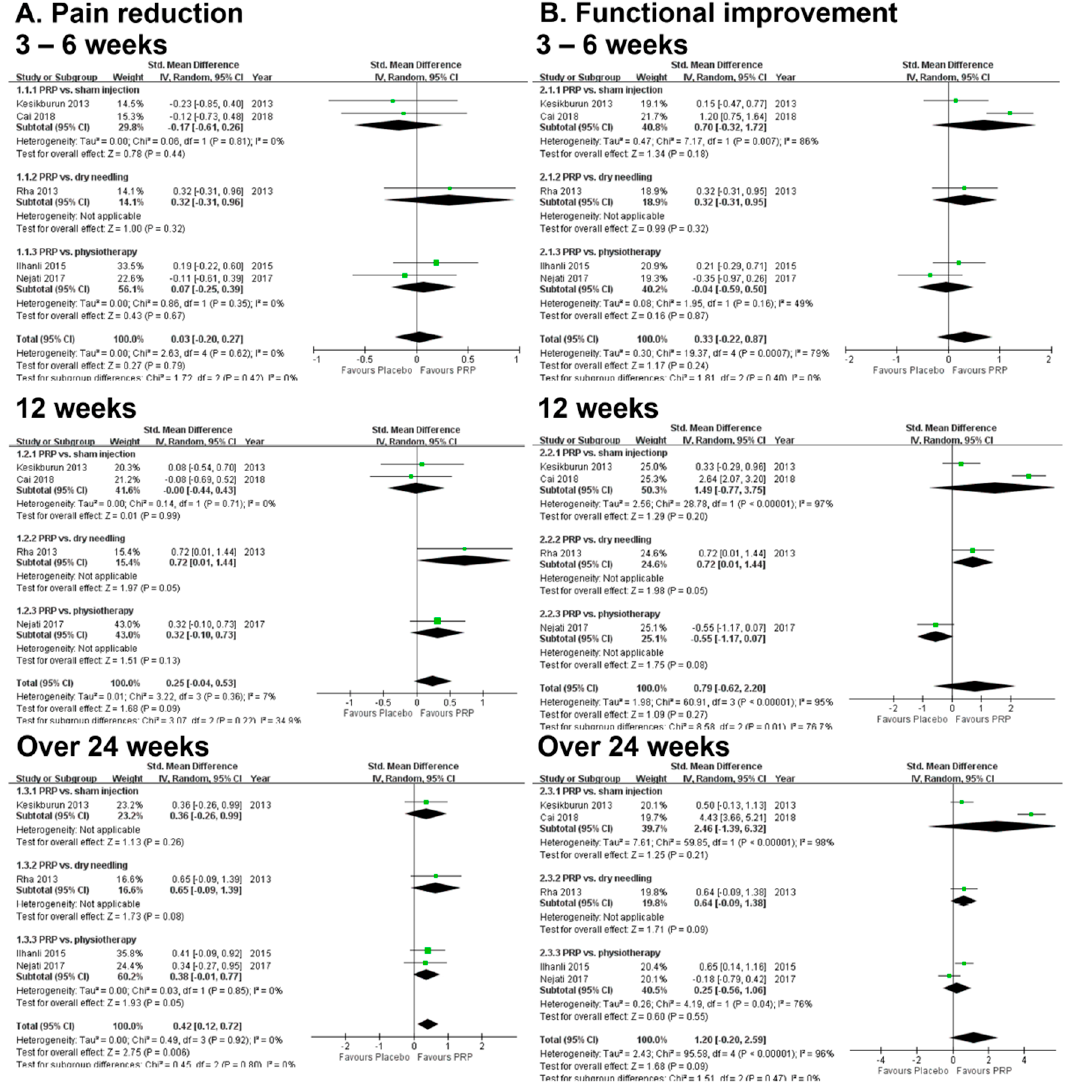
Figure 5. Forest plots of subgroup analysis: comparison between PRP and control groups including sham injection, dry needing, and physiotherapy in pain reduction ( A ) and functional improvement ( B ) at the short term (3–6 weeks), the medium term(12 weeks), and the long term(over 24 weeks). Abbreviation: PRP, platelet-rich plasma.